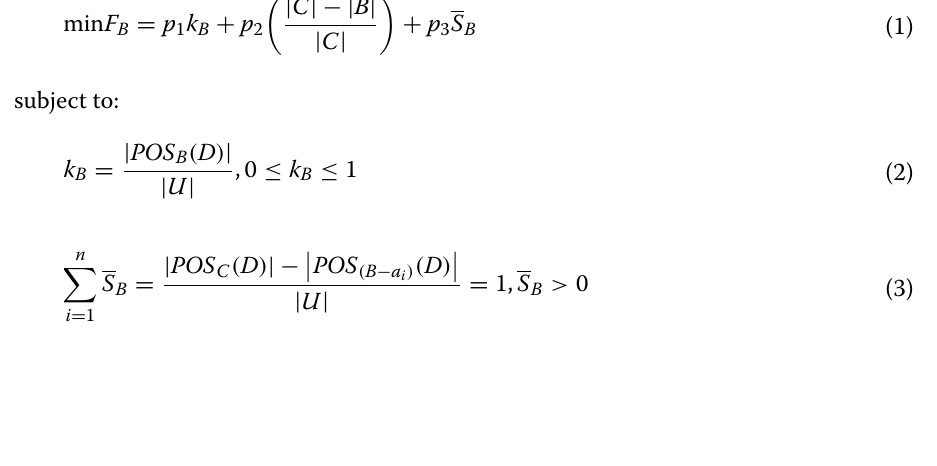
Set of observations, indexed by x